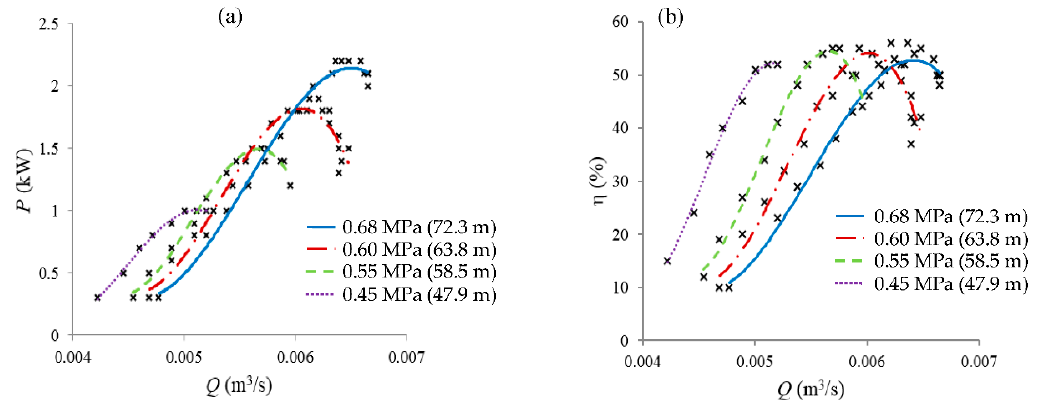
Figure 10. Characteristic ERPR curves of: ( a ) PEU active power; and ( b ) total efficiency in flow-rate domain under four reduced pressure values.